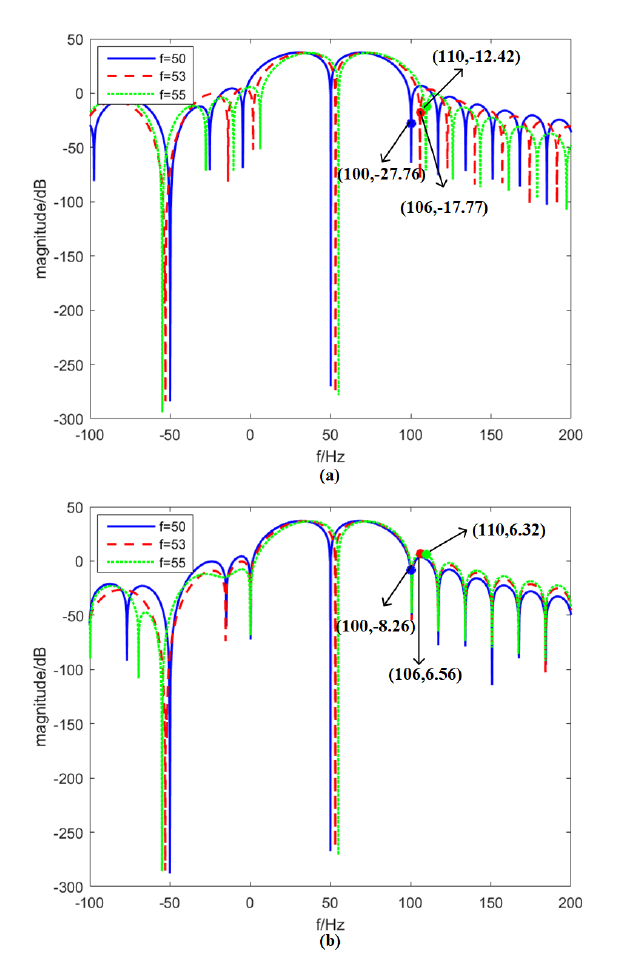
Figure 4. Instantaneous frequency response of the e-IpD 2 FT and IpD 2 FT for p 1 estimation. The three-cycle Hanning window is chosen for illustration. f is set at 50, 53 and 55 Hz, respectively: ( a ) e-IpD 2 FT; and ( b ) IpD 2